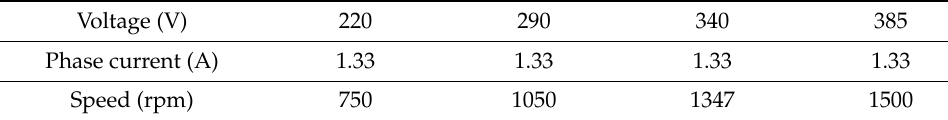
Table 5. No-load test result of the SynRM.